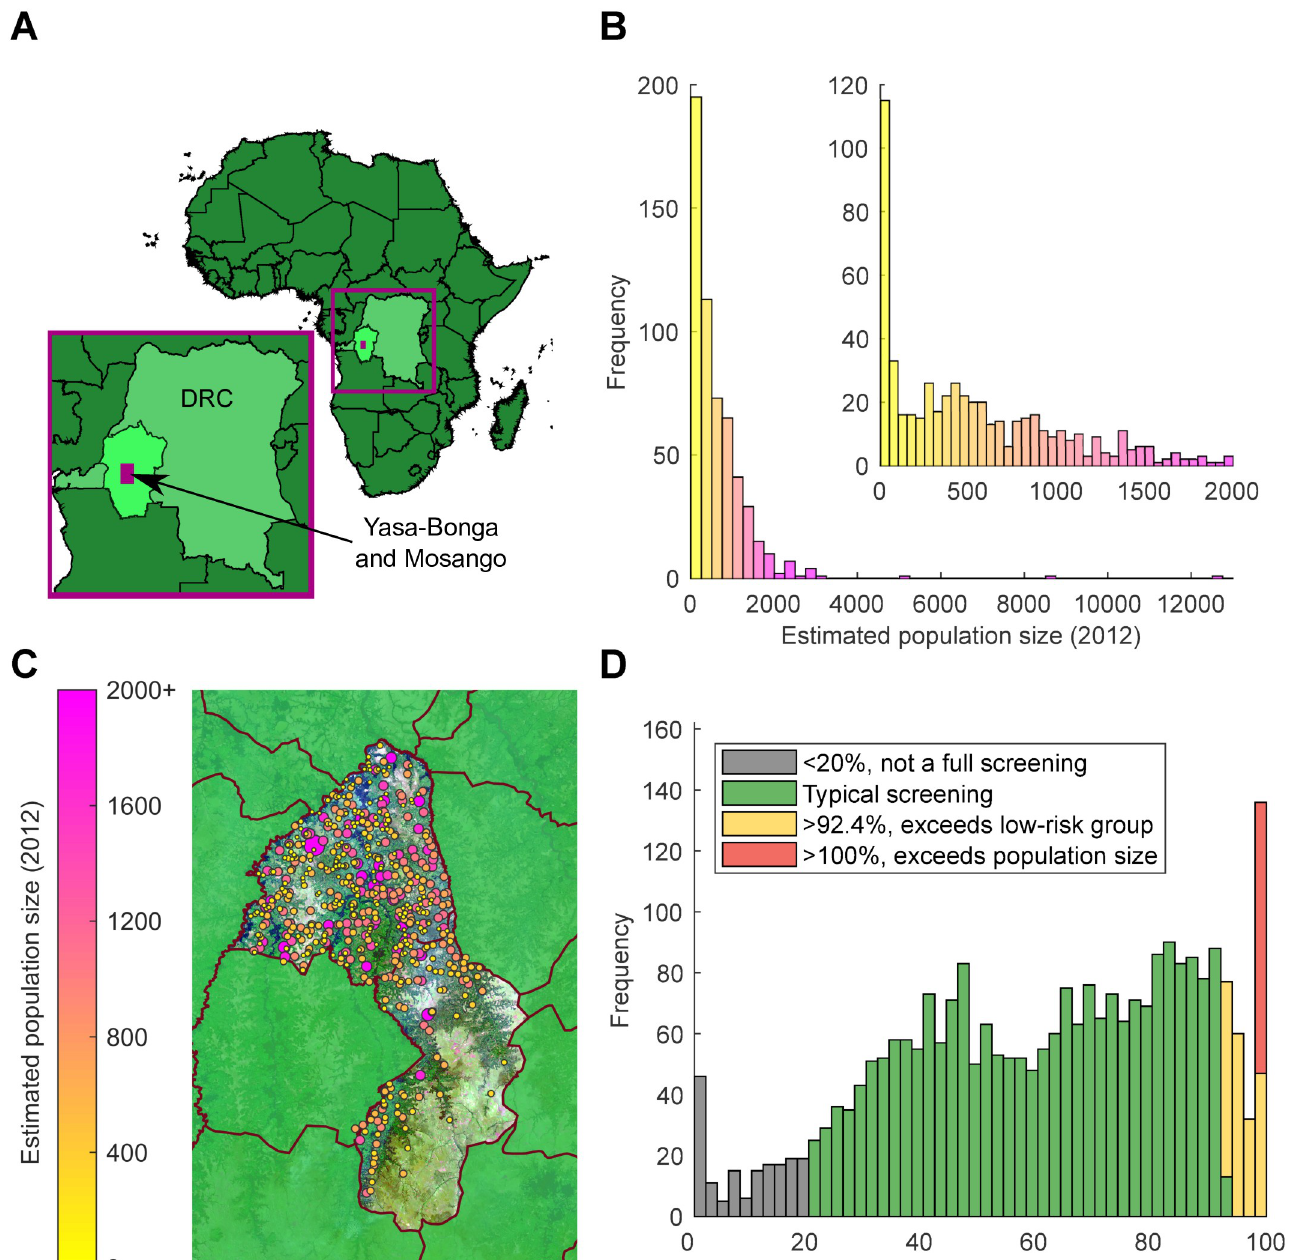
Fig 1. Visualisation of WHO HAT Atlas data for the study health zones: Yasa-Bonga and Mosango. (A) Map of Africa, showing the DRC (lighter green) with former Bandundu province highlighted in the lightest green. The area containing the health zones Yasa-Bonga and Mosango (presented in more detail in Fig 1C) is covered in a purple box. (B) Histograms of the estimated population sizes of villages in the region for 2012. The inset figure highlights the distribution of population sizes less than 2,000 individuals. Population sizes have a range of 3 to 12,645. (C) Detailed map of locations of settlements within the study region (Fig 1A, purple box), colour and radius of the circle represent population size of the individual settlements. The satellite image shown for the Yasa-Bonga and Mosango health zones is from Landsat-8 accessed through https://earthexplorer.usgs.gov/ from the U.S. Geological Survey. (D) Histogram of the coverage achieved in visits to settlements as part of the active screening programme. When annual screenings are larger than the estimated accessible population (yellow and red bars), this may indicate either multiple screenings in a given year, or misreporting, when individuals are attending from neighbouring settlements.